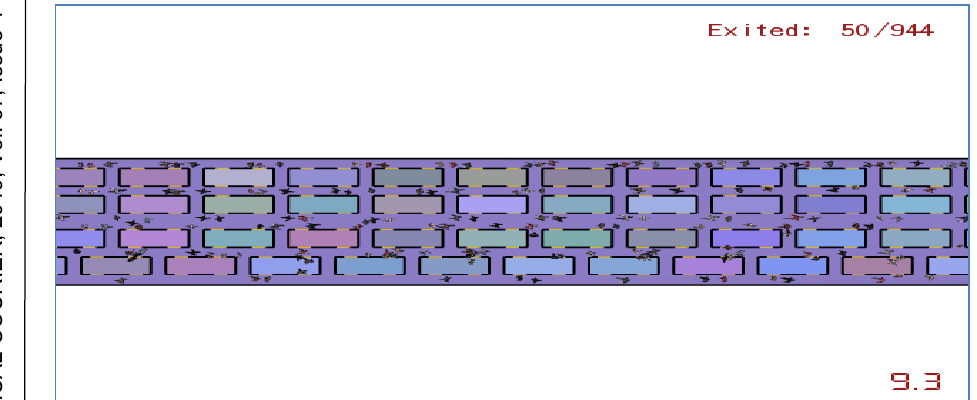
Figure 6 – Simulation example for the first scenario after 9.3 seconds from the start of the simulation